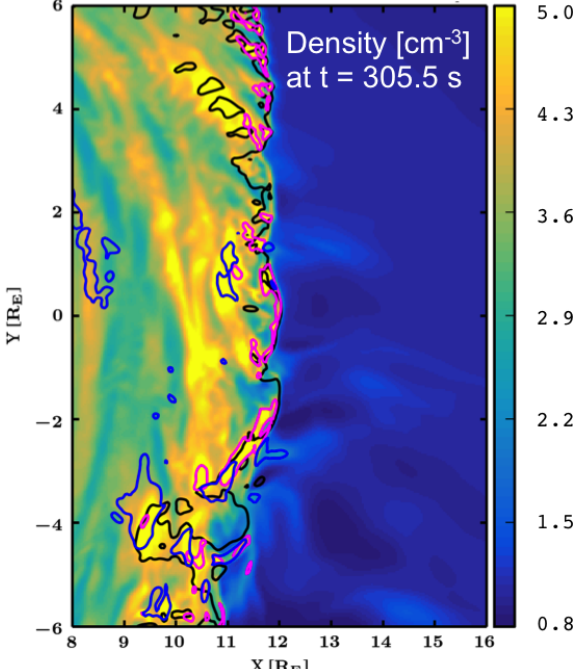
Figure 5. All criteria with density color coded at t = 305 . 5s. The Karlsson criterion C K in Eq. (3) is given with magenta, the Archer and Horbury criterion C A in Eq. (2) with blue, and the Plaschke criterion C P in Eq. (1) with black.